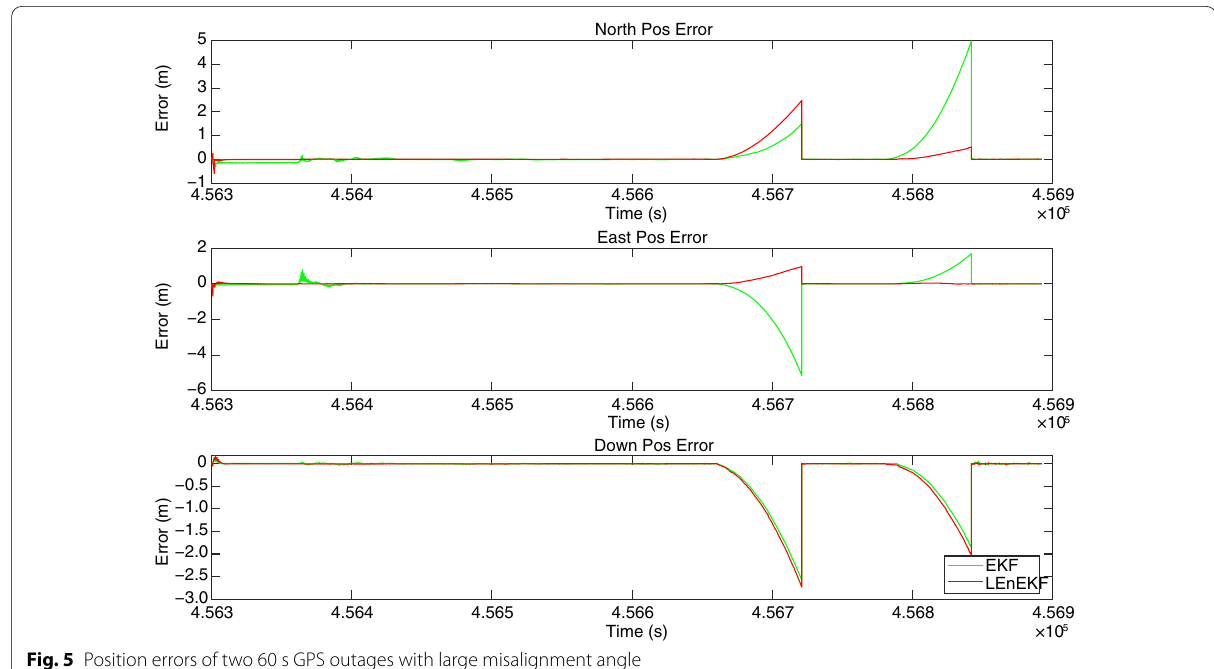
Fig. 5 Position errors of two 60 s GPS outages with large misalignment angle